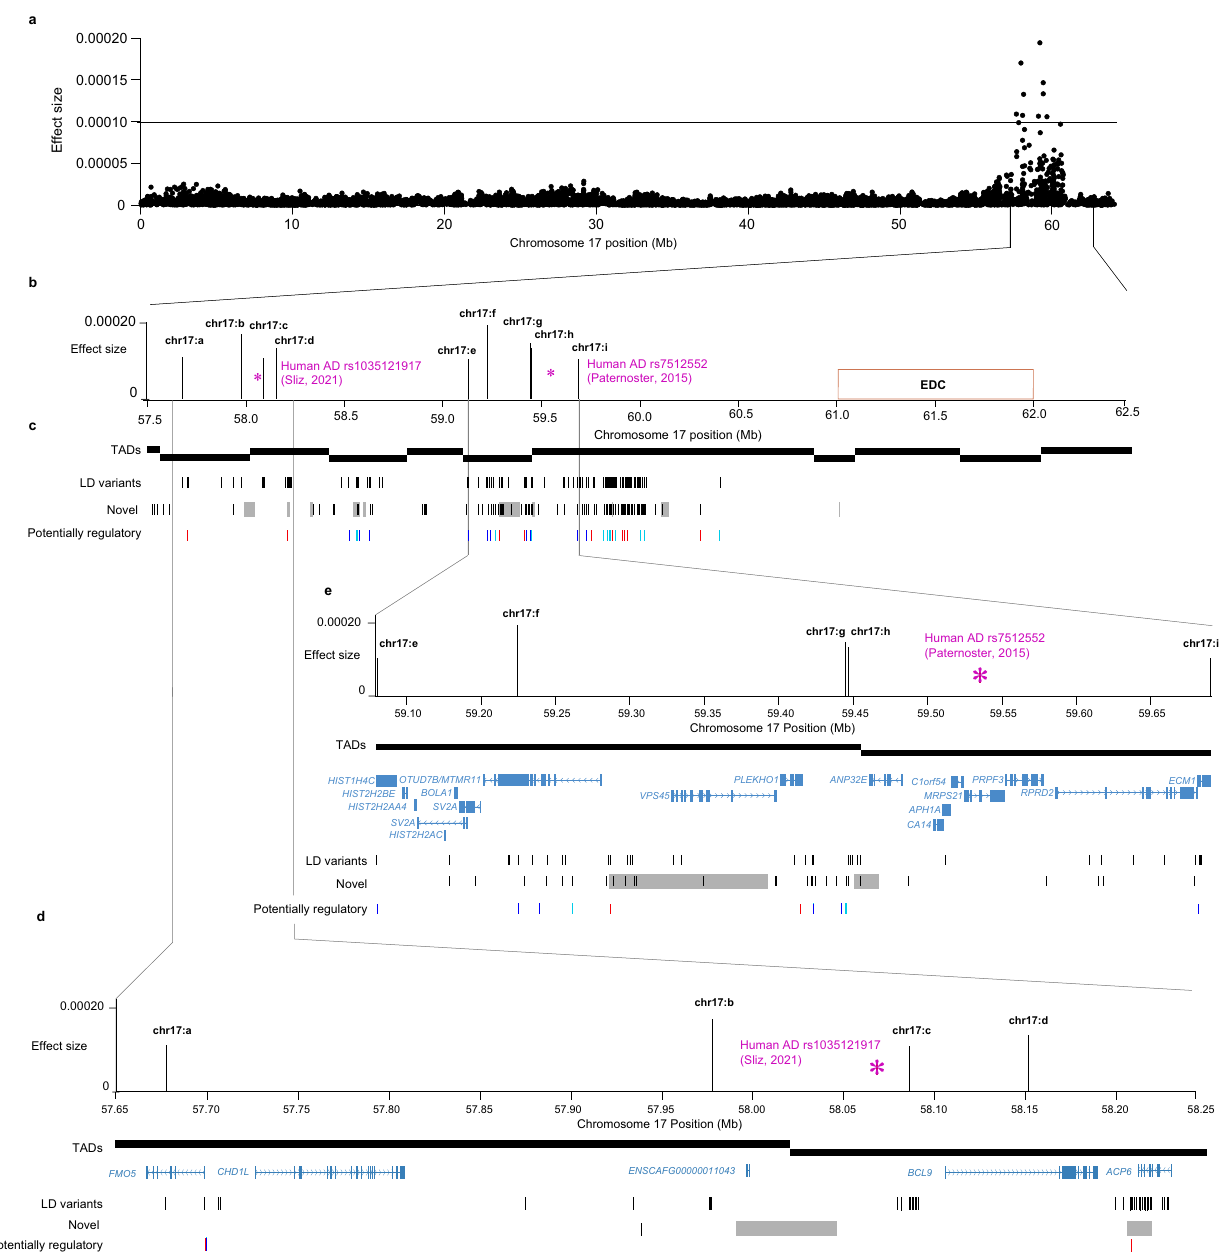
Fig. 3 Canine AD-associated locus on chromosome 17 in Labrador retrievers. One AD-associated locus in LR was located on chromosome 17 ( a ) with nine effect variants comprising a region of ~2 Mb. One of the top associated variants in human AD meta-GWAS 7 (Sliz et al., 2021, purple) was located ~14 kb from effect variant chr17:c and one AD-associated SNP from the human AD multi-ancestry meta-GWAS 6 (Paternoster et al., 2015, purple) was located in between variants chr17:h and chr17:i. Variants con fi rmed in sequenced dogs and in LD ( r 2 > 0.8) with at least one of the effect variants extend >3 Mb (57.09 – 60.41 Mb), about 0.5 Mb from the epidermal differentiation complex (EDC) gene region ( b ). Black blocks show liver TADs in dogs. Black bars show 236 LD variants (plus two outside the fi gure boundaries at ~57.1 – 57.3 Mb) and 129 novel variants (plus four at ~57.3 Mb outside the fi gure boundaries). Variants with potentially regulatory functions are highlighted in light blue (overlap with canine ATAC-seq or both ATAC and cCRE), dark blue (ATAC and GeneHancer elements), and red (both ATAC, GeneHancer, and cCRE). Gray blocks show homozygous regions unique to the two ONT sequenced controls and not detected in the two sequenced cases ( c ). One homozygous region (56 kb) was found between effect variants chr17:b-c upstream of BCL9 , and another region of homozygosity (14 kb) was spanning half of ACP6 ( d ). One 106 kb homozygous region, including six LD-variants and fi ve novel variants, overlapped the VPS45 gene ( e